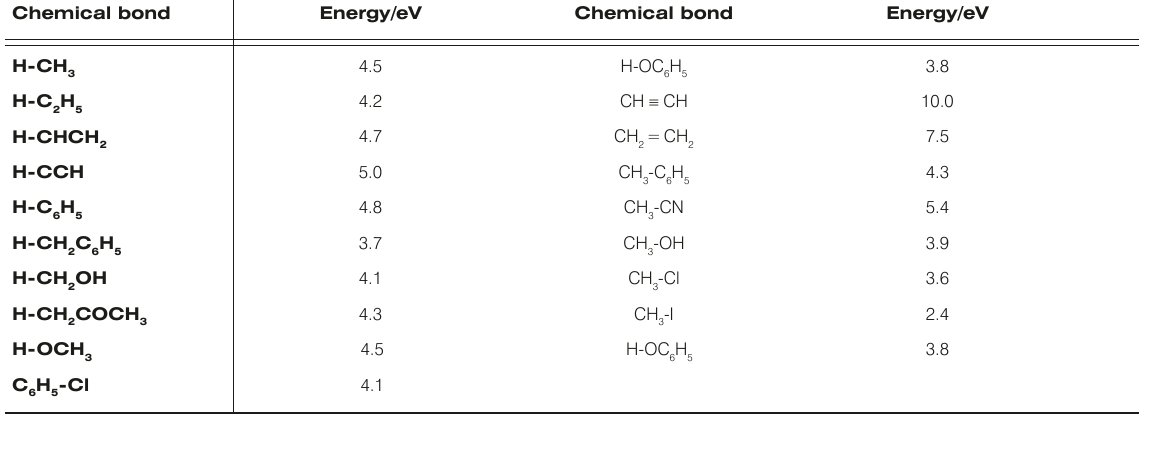
Table 3. The binding energy in organic substrates.